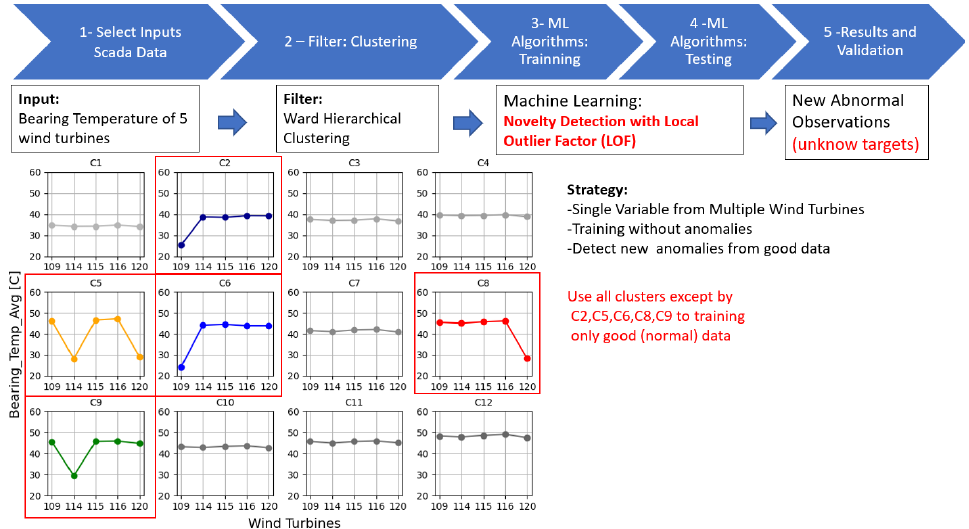
Figure 5. Overview of the WHC-LOF method that combines Ward Hierarchical Clustering (WHC) for the filter process and Novelty Detection with Local Outlier Factor (LOF) for detecting the anomalies where only the good (normal) data is used to train (red